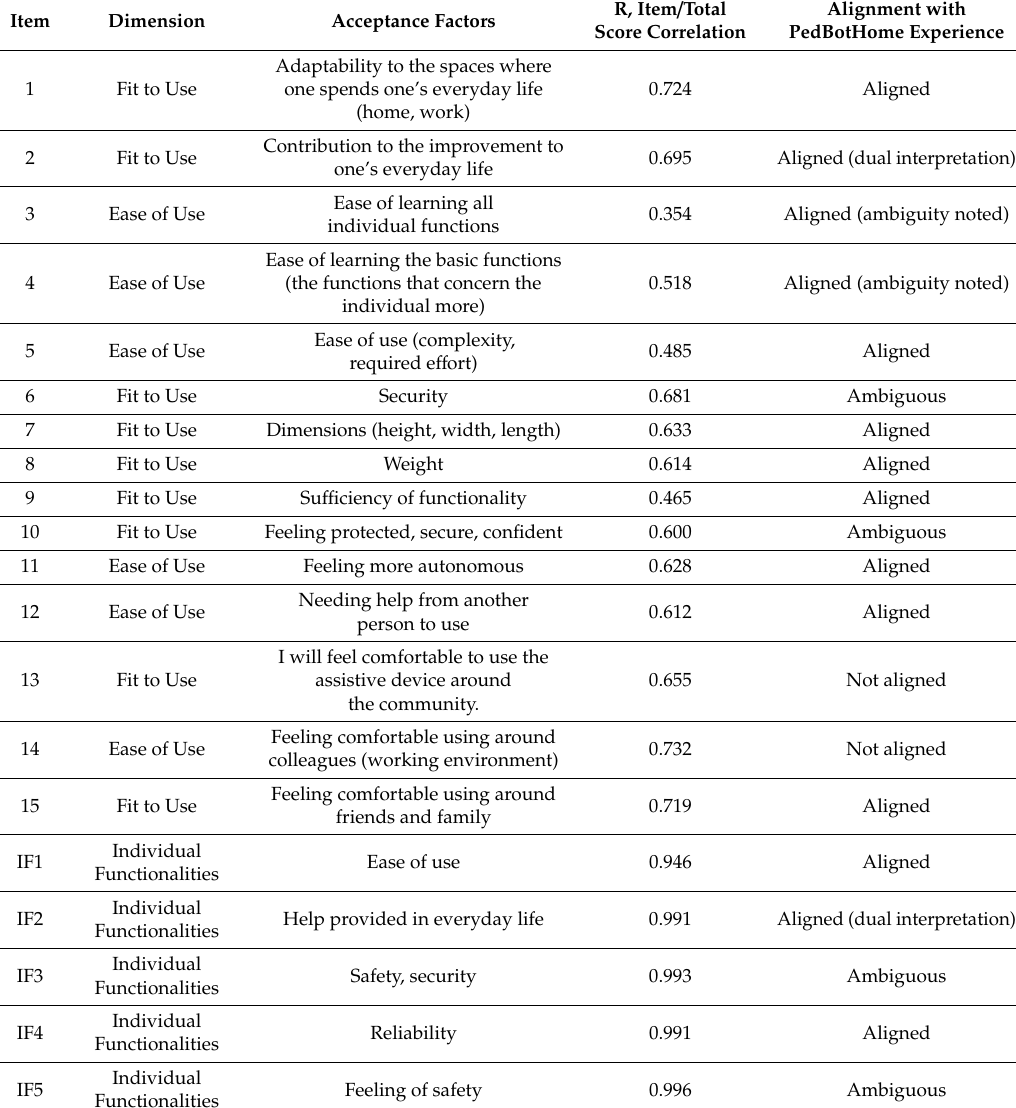
Table 4. PYTHEIA [31] scale items alignment with PedBotHome